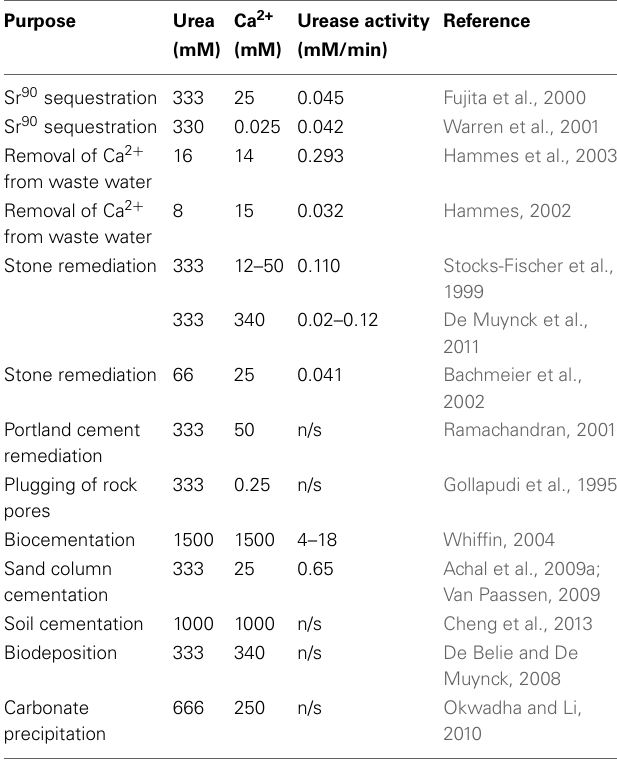
Table 1 | Reaction conditions reported in the literature for production of CaCO 3 via urea